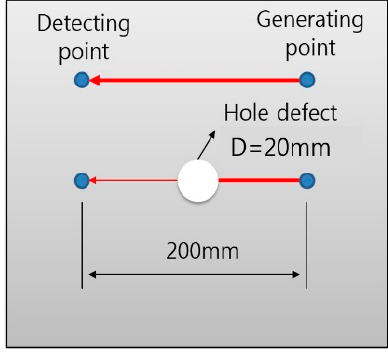
Figure 20. The schematic of the defect-detecting experiment.